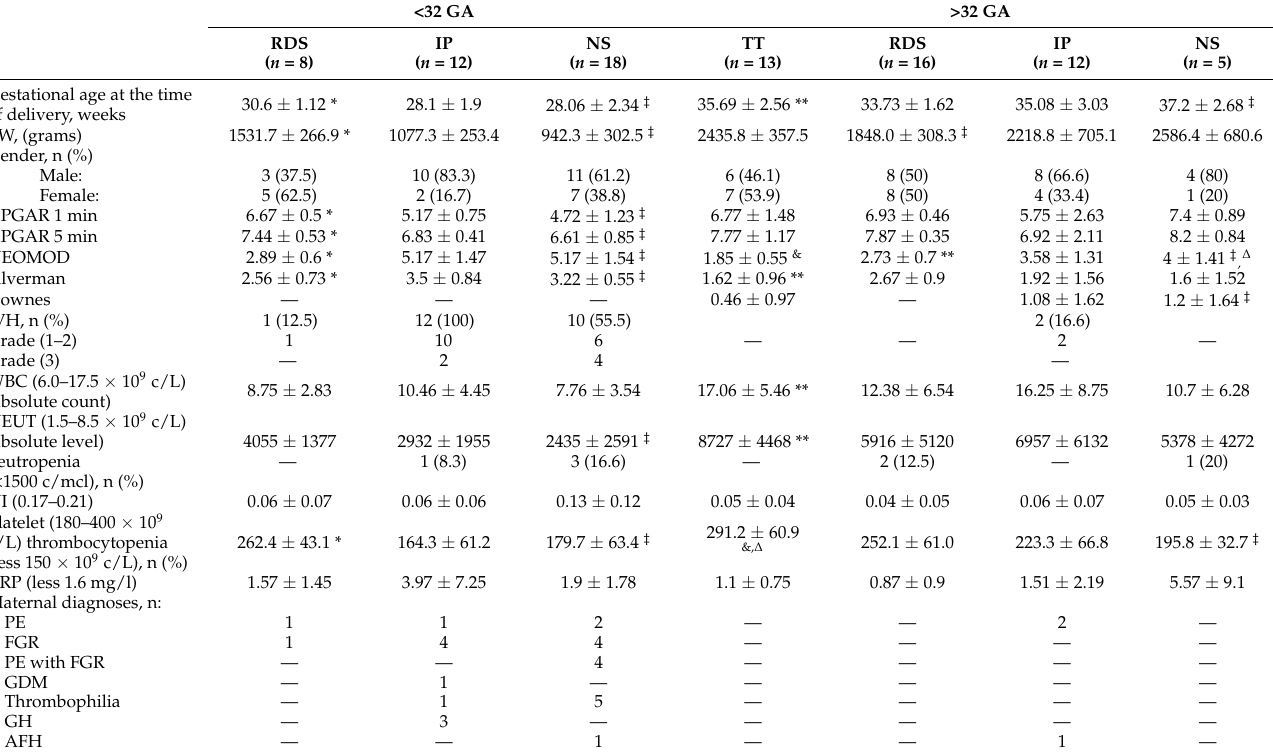
Table 1. Clinical characteristic of newborns with adverse outcomes (Cohort II) and maternal diagnoses. <32 GA >32